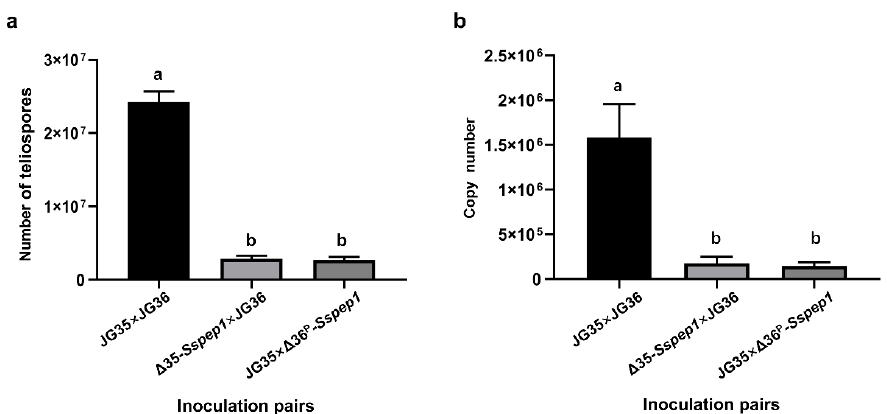
Figure 6. Sspep1 deletion mutants were impaired in growth and development in the host. ( a ) Teliospores developed in infected plantlets. Data were from four whips and are expressed as numbers of teliospores per cm of whip. ( b ) Quantification of S. scitamineum -specific pra1 gene copy number in the whips. The coding sequence of the pra1 gene of S. scitamineum was amplified and cloned into